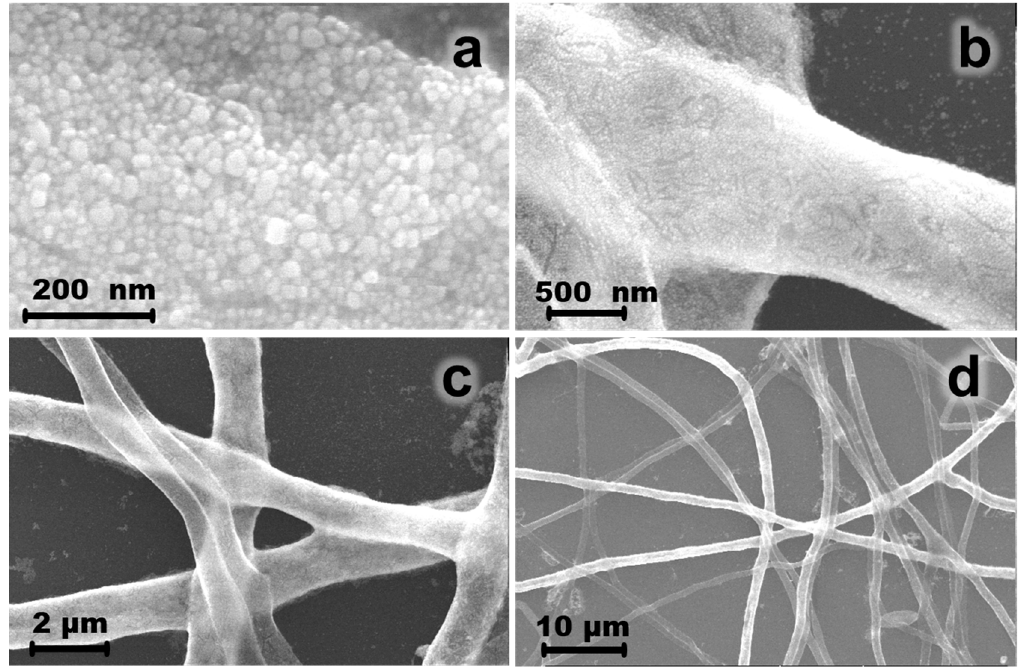
Figure 2. SEM images with different magnifications ( a – d ) of the microtubules fabricated using the fungus Cladosporium sphaerospermum covered with gold nanoparticles (FG) deposited on a silicon